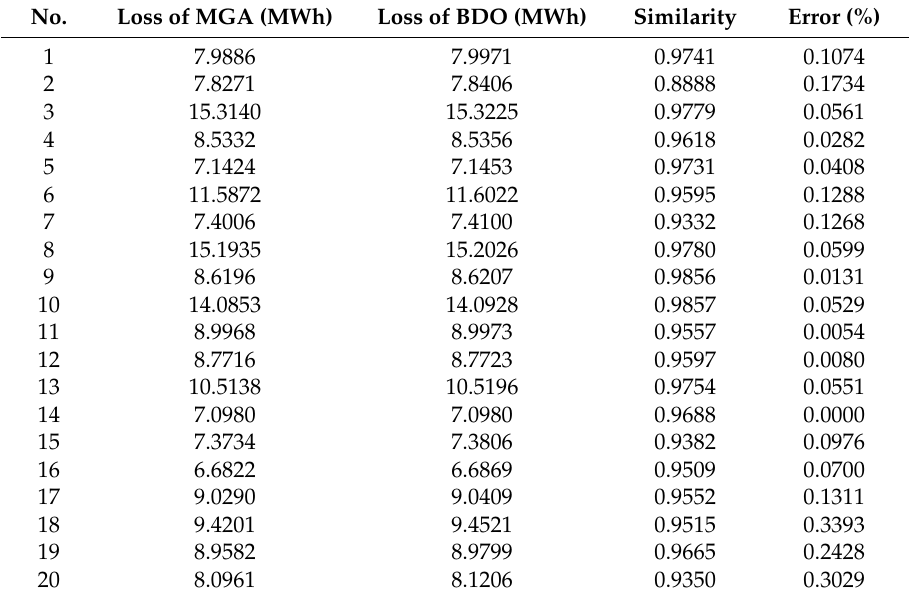
Figure 7. Distribution of load similarity and loss error. Table 4. Optimization result of MGA (multi-population genetic algorithm) and BDO (big data reactive power optimization) without fine adjustment.